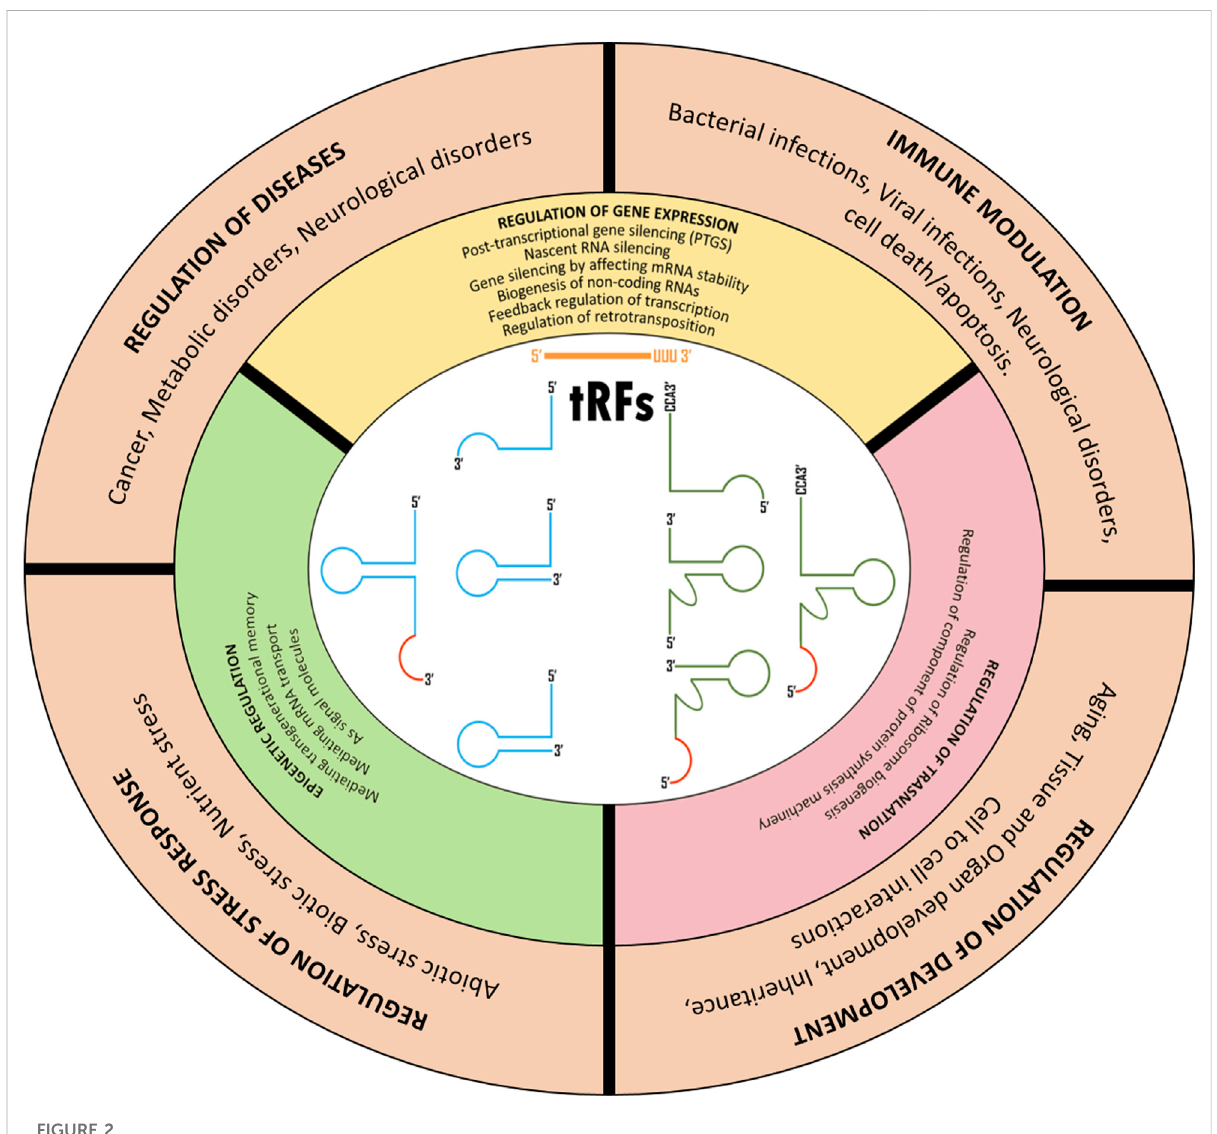
FIGURE 2 Cellular roles of tRNA derive